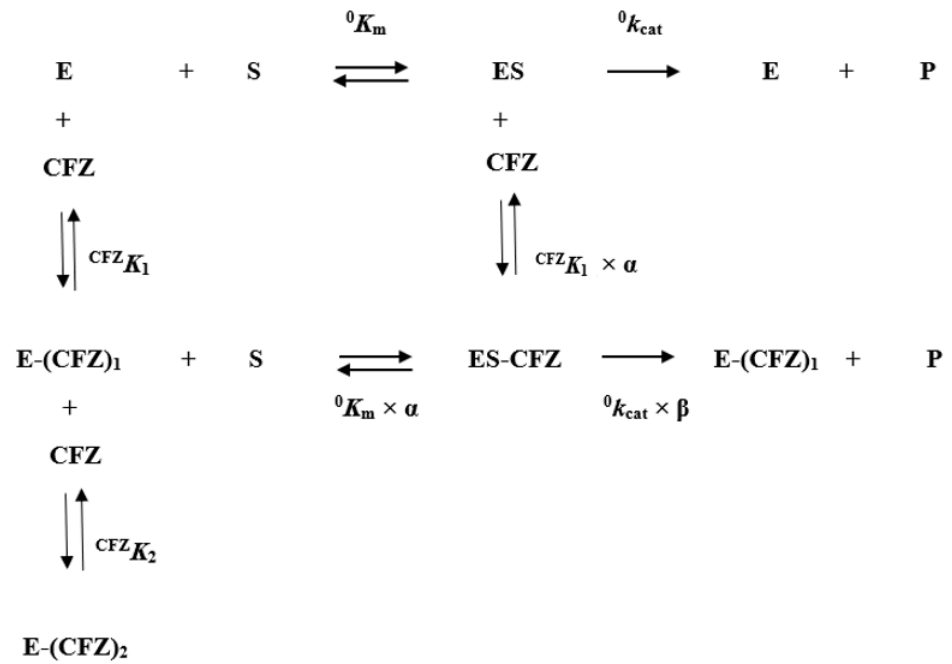
Scheme 2. Proposed interactions between IDE and CFZ, where 0 k cat and 0 K m are the rate-limiting step and the Michaelis–Menten constant for the enzymatic activity of IDE, respectively, in the absence of CFZ, 1 K CFZ and 2 K CFZ are the CFZ dissociation equilibrium constant to free IDE for the first allosteric site and the second inhibitory site, respectively. Furthermore, α is the interaction parameter describing the linked allosteric effect between CFZ and substrate binding ( α < 1 indicating a positive cooperative effect, α > 1 envisaging a negative cooperative effect, and α = 1 corresponding to no reciprocal effect). On the other hand, β reflects the effect of CFZ binding on the rate-limiting step ( β > 1 indicating a CFZ-linked increase of k cat and β < 1 corresponding to a CFZ-linked decrease of k cat , with β = 1 reflecting the lack of a CFZ-linked effect on k cat ).